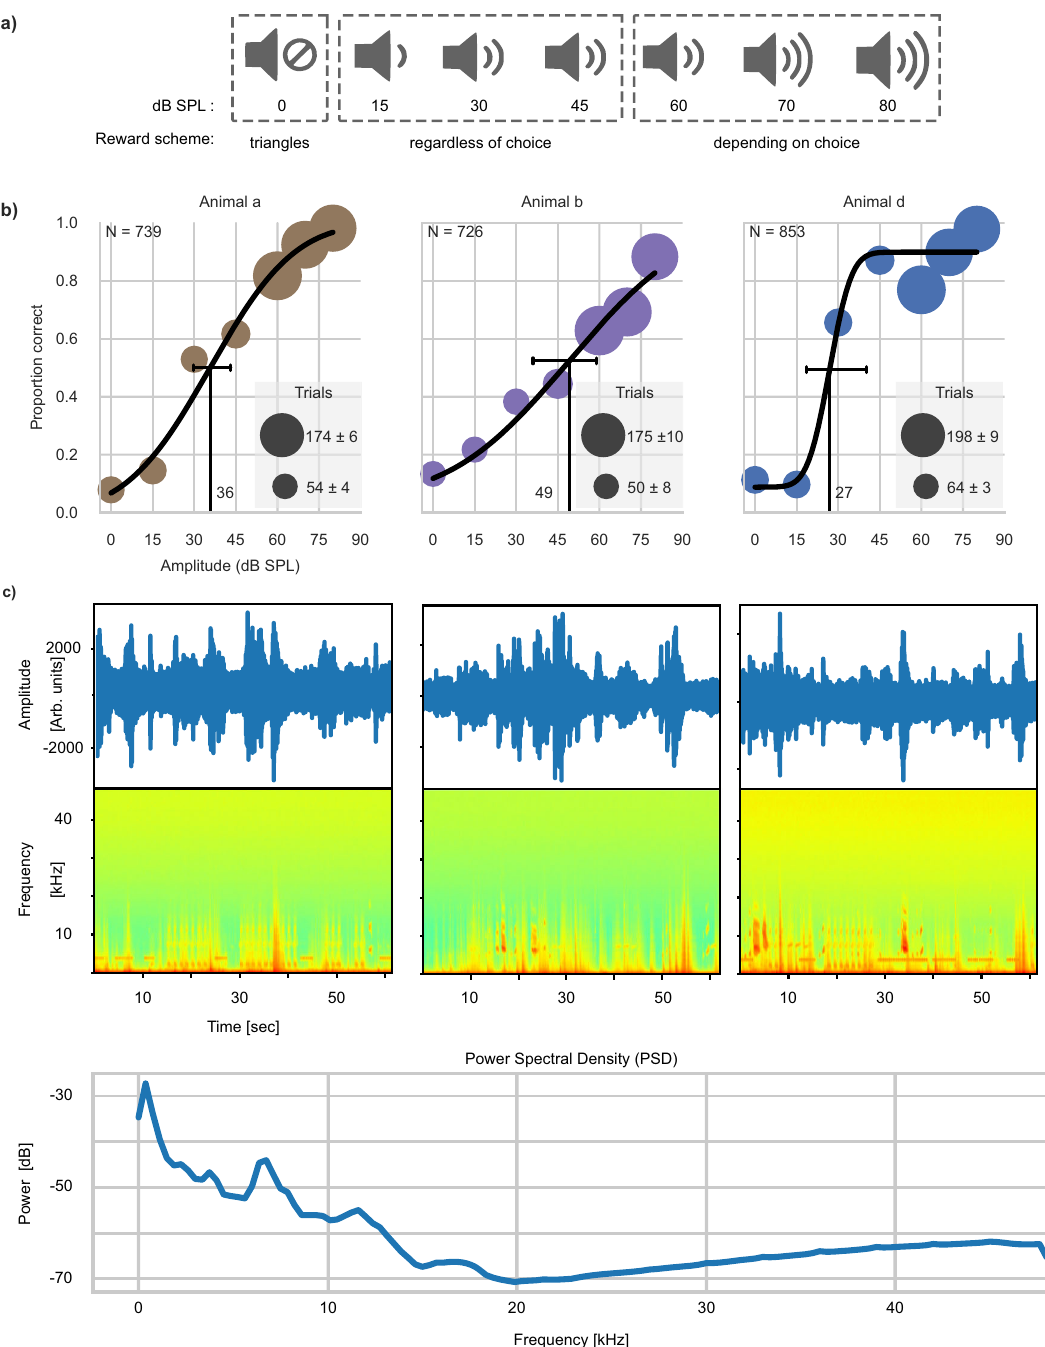
Fig. 5 Psychophysical assessment of hearing thresholds for animals a, b, and d after training on the Audio-visual association experiment. a Schematic representation of the sound levels used and the reward scheme associated with each level. Upon presentation of the vocalization stimulus: at 0 dB SPL, only the selection of the triangles was rewarded. For intensities 15, 30, and 45 dB SPL the animal was rewarded regardless of choice. For intensities at and above 60 dB SPL the reward was delivered depending on the animal ’ s choice. b Psychometric estimation of hearing thresholds (black vertical lines) based on the proportion of times the animals selected the correct response across the intensities used. 95% con fi dence intervals (CI) are indicated with black horizontal lines (Animal a: threshold 36 dB SPL; CI between 29 and 43; b: 49 dB SPL, CI between 36 and 58; d: 27 dB SPL, CI between 27 and 40). c waveforms and spectrograms of 3 one-minute-long snippets recorded inside an MXBI while another MXBI in the same colony room was used to gather data for the audio- visual association experiment. Bottom panel shows the power spectral density of a 5 h long recording with dominant peaks at 6, 12, and 18 kHz caused by